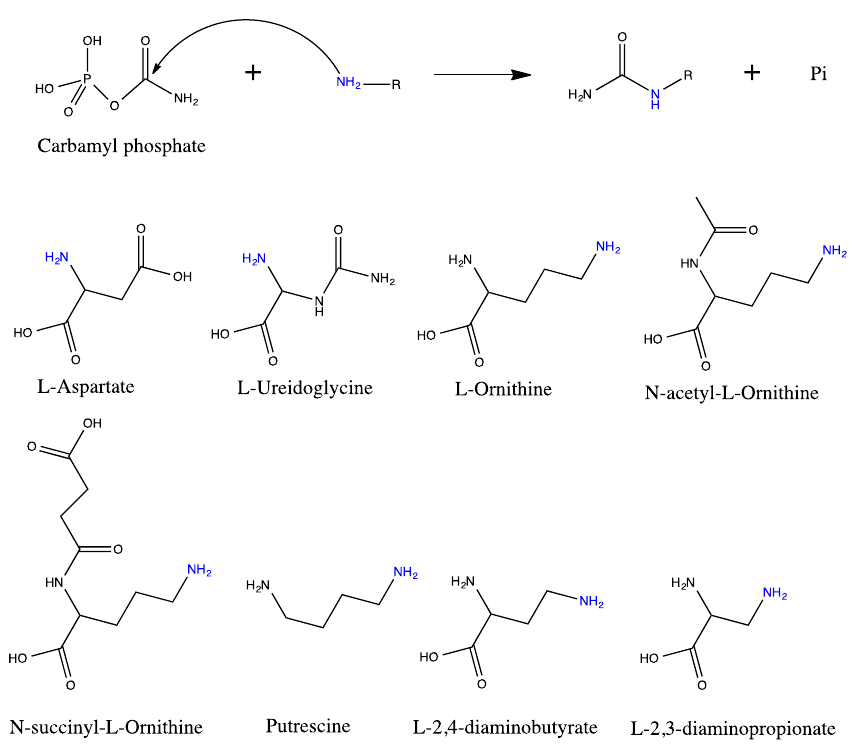
Figure 1. Schematic drawing of the carbamyltransferase reactions and the structures of its substrates. Carbamyltransferase catalyzes the transfer of a carbamyl group from carbamyl phosphate to the amino group (colored as blue) of the second substrate. The forward reaction is catalyzed by anabolic enzymes and the reverse reaction by catabolic enzymes. The forward reaction is kinetically